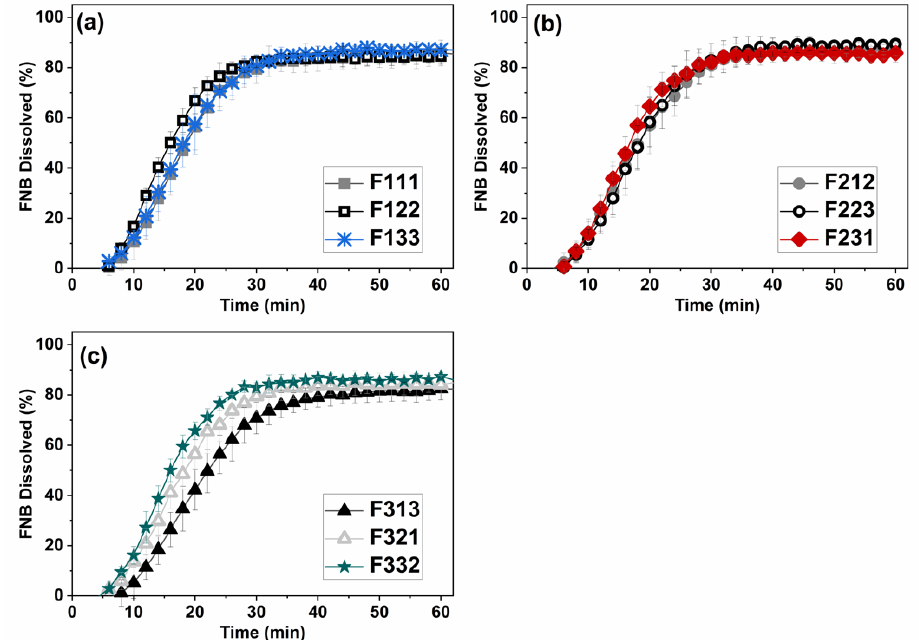
Figure 7. Dissolution profiles of dry films at ~23 wt% AR-FNB concentrations processed with: ( a ) Impeller mixer, ( b ) Planetary mixer, and ( c ) High-intensity vibrational mixer.